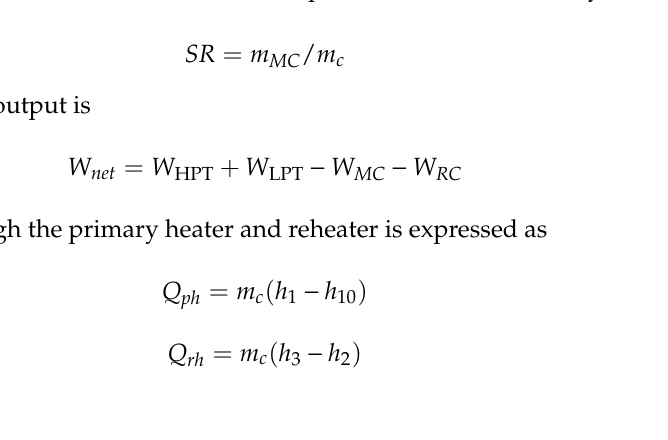
Figure 4. Critical pressure of mixtures at different mass fractions of CO 2 .